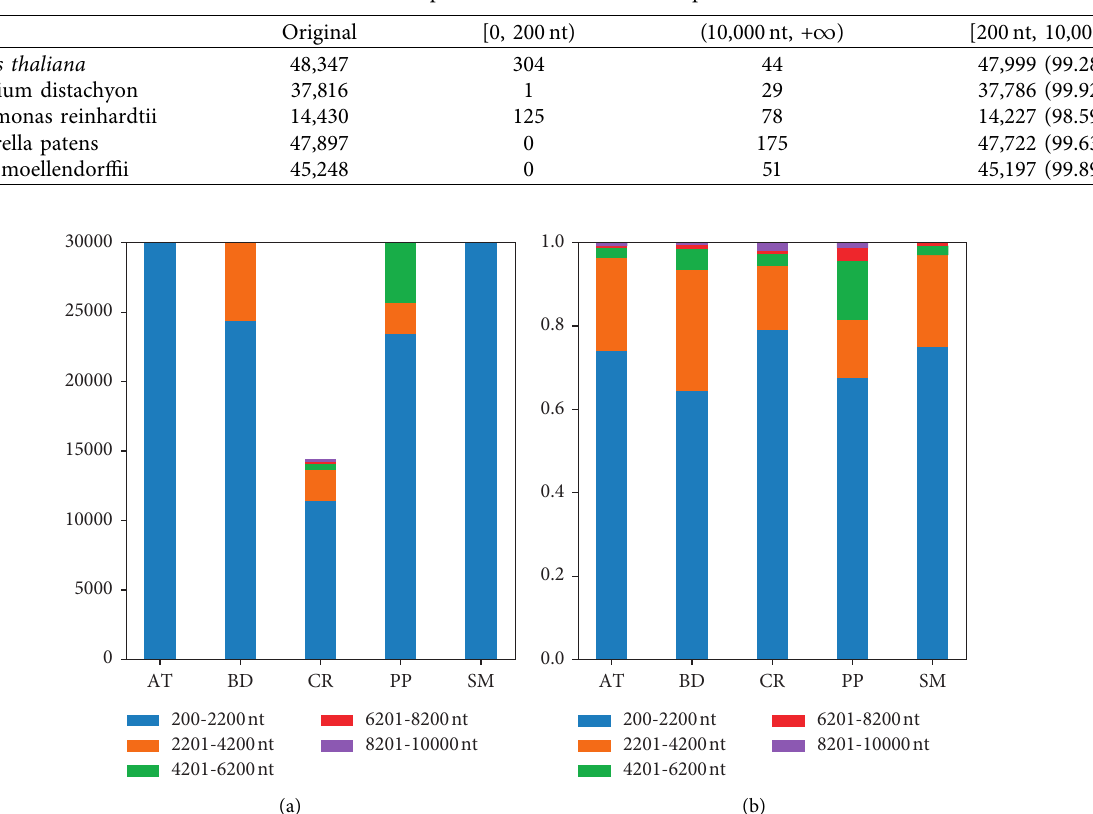
Figure 2: Distribution of mRNA sequence lengths of the five different plants. (a) Number of mRNAs in each interval. (b) Corresponding frequency. Table 2: Numeric description of the lncRNA and mRNA data sets used to build the model.